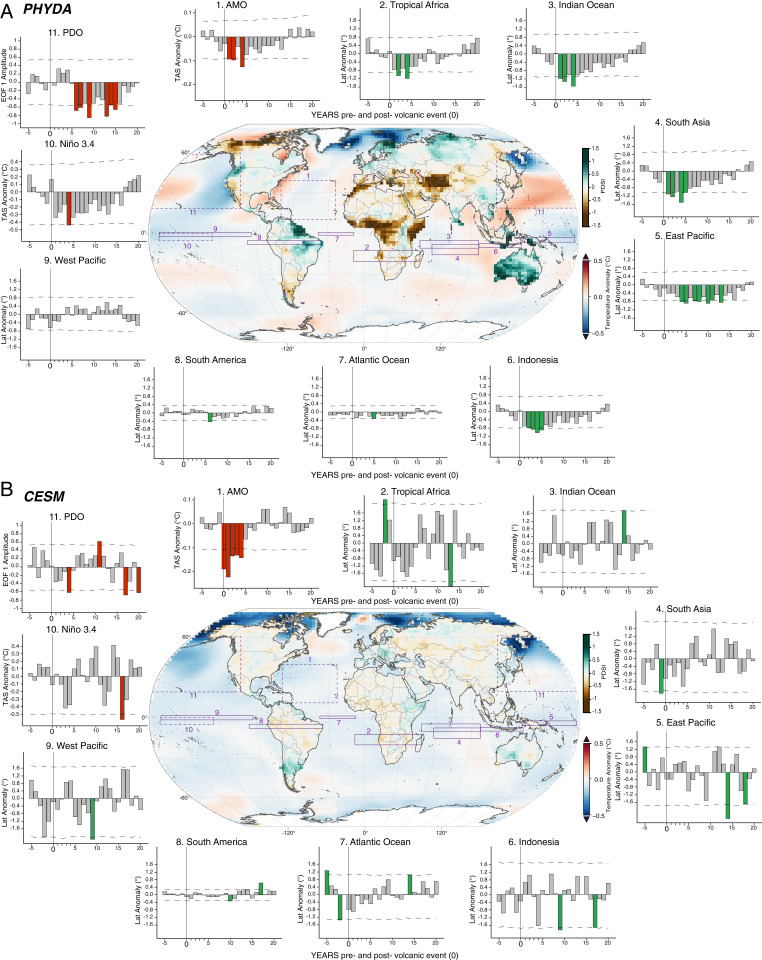
Climate system response in PHYDA and CESM to last millennium large TVEs in the boreal winter. (A) Map in center of the panel shows the weighted mean (years +0 to +20) state of the 2-m marine air temperature (ocean) and hydroclimate (land) after TVEP in DJF using PHYDA. Values that do not satisfy the significance threshold (P < 0.05) are excluded. The purple boxes in the map indicate the domain of the ITCZ (over ocean)/precipitation (over land), including the extent of the latitudinal shift in DJF. Bar plots (with corresponding numbers) show changes in latitude of ITCZ/precipitation domains from year −5 to +20, with significant changes (at 95% confidence level) colored in green. Dashed purple boxes in the map (numbers 1, 10, and 11) indicate AMO, ENSO, and PDO domains, and the corresponding bar plots show significant changes (at 95% confidence level) in 2-m marine air temperature colored in red. (B) As in A, except using output from CESM ensemble member 10.